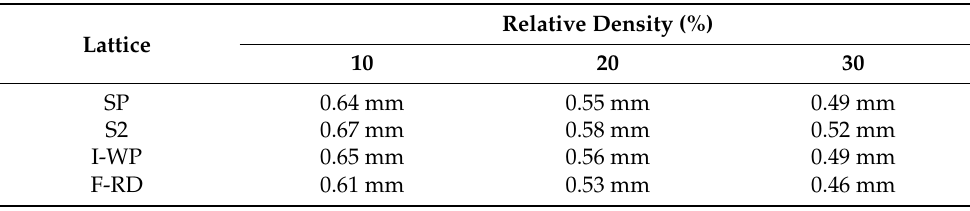
Table 8. Deformation along the Z -axis.